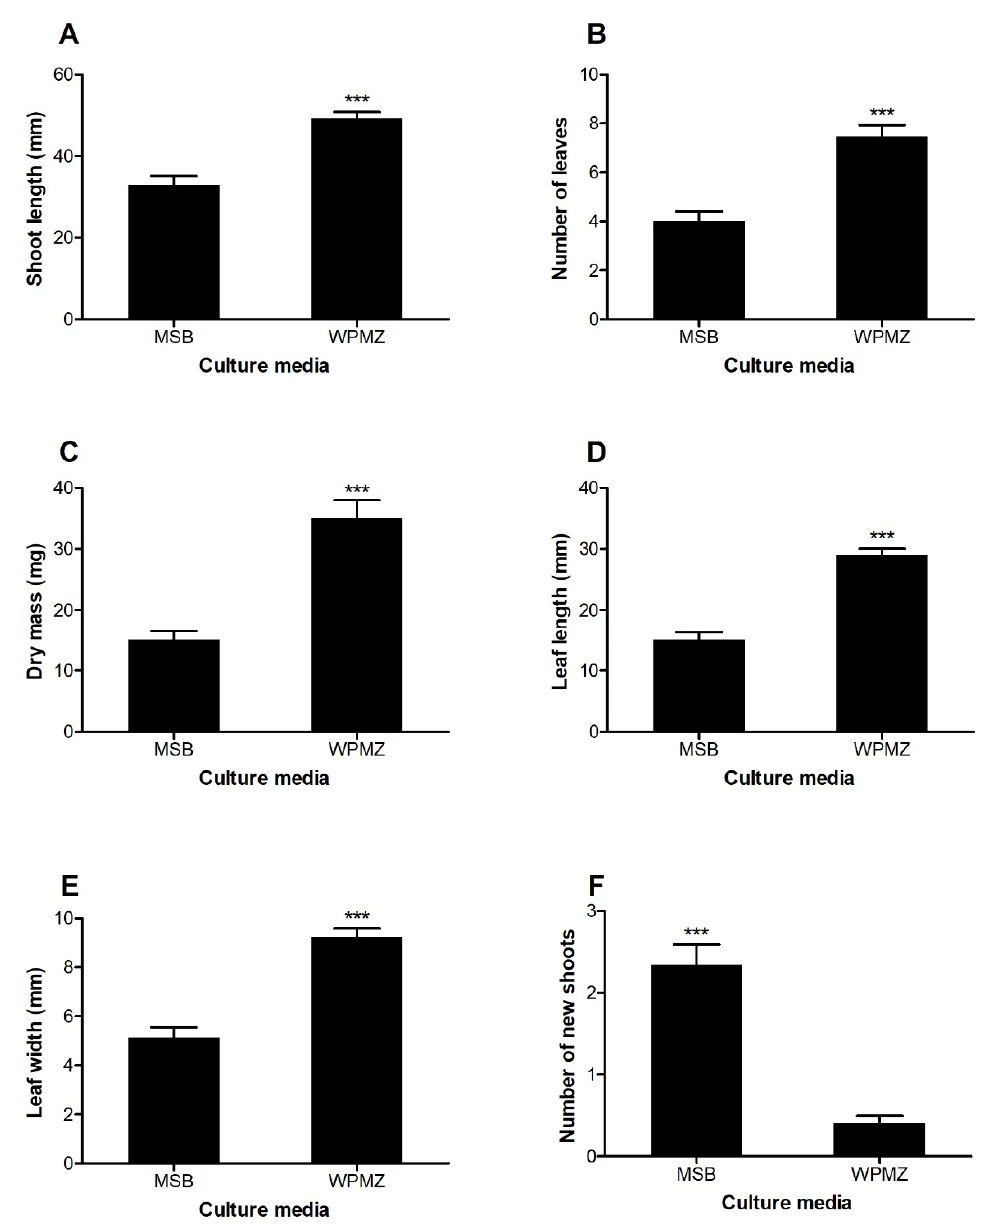
Figure 1. E ff ects of MSB and WPMZ media on the ( A ) shoot length, ( B ) number of leaves, ( C ) dry mass, ( D ) leaf length, ( E ) leaf width and ( F ) and number of new shoots of SM904 chestnut hybrid. Bars indicate standard error of the mean of 45 shoots. Significant di ff erences are indicated with *** ( p < 0.001; Mann–Whitney test).